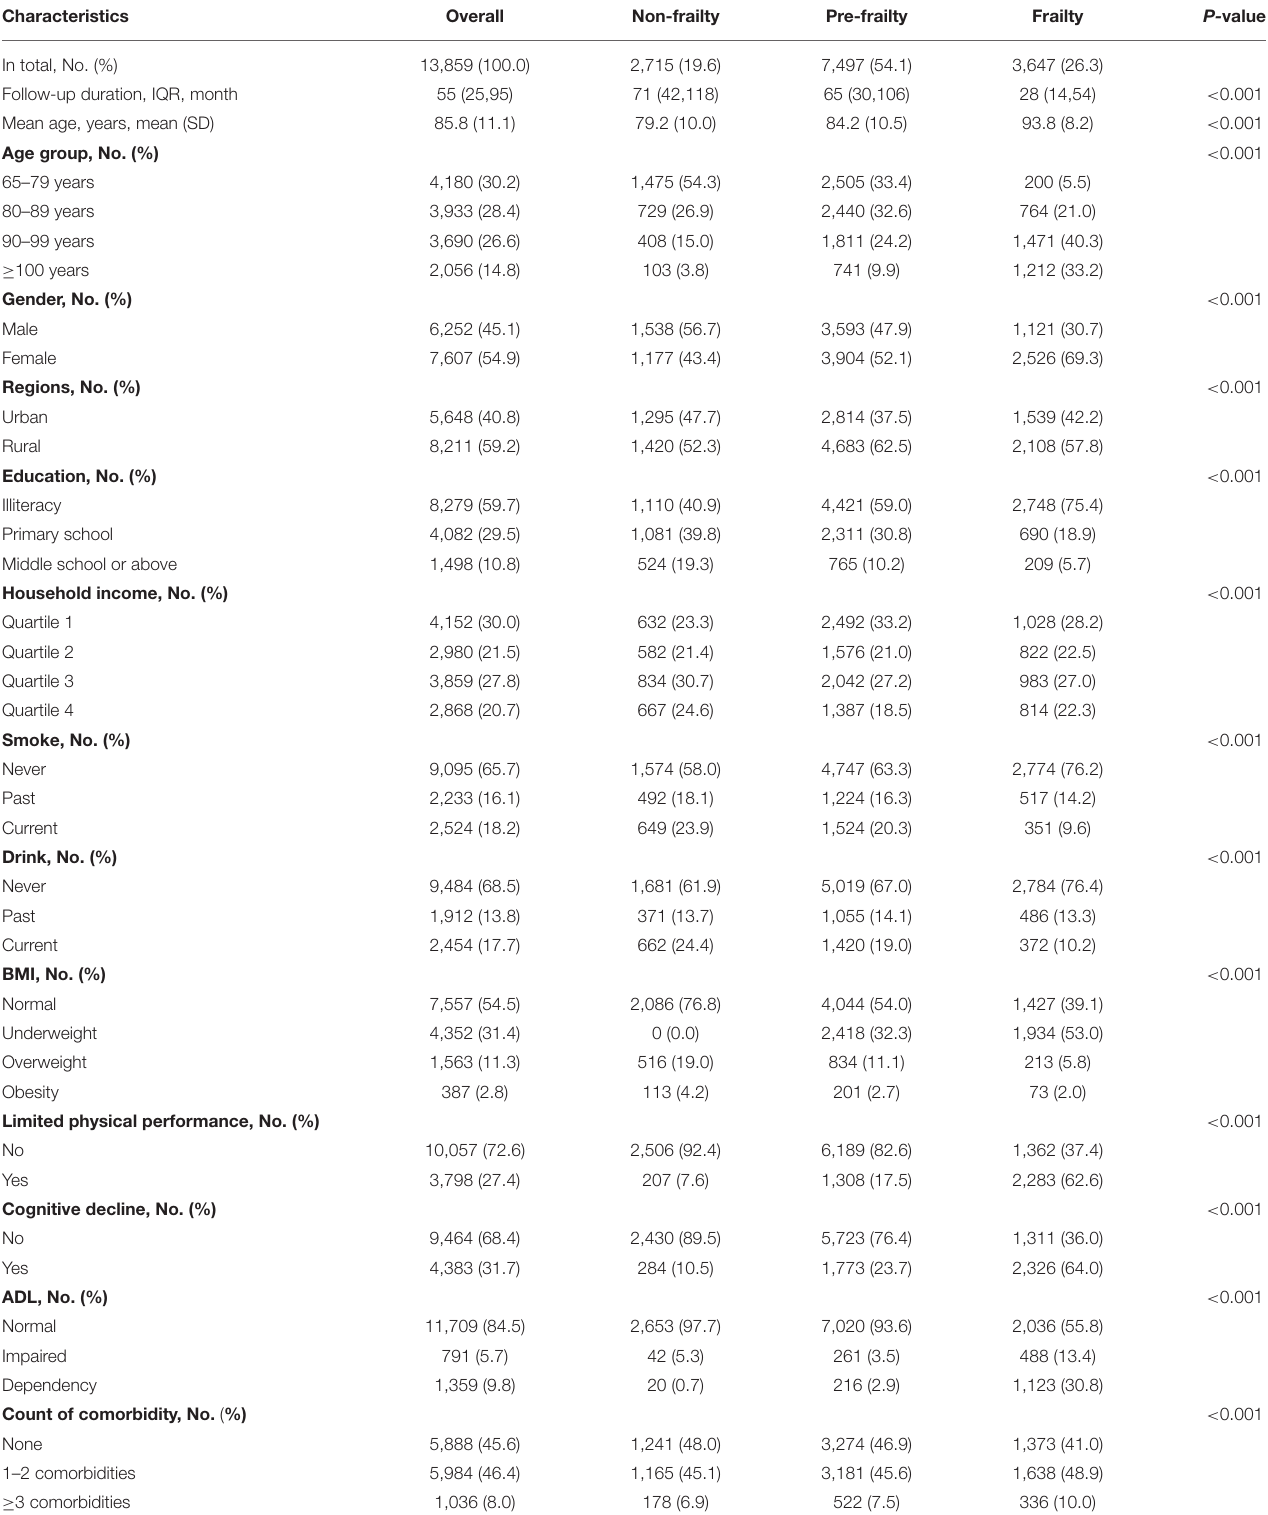
TABLE 1 | Comparison of characteristics among participants in different status of frailty at baseline. Characteristics Overall Non-frailty Pre-frailty Frailty P-